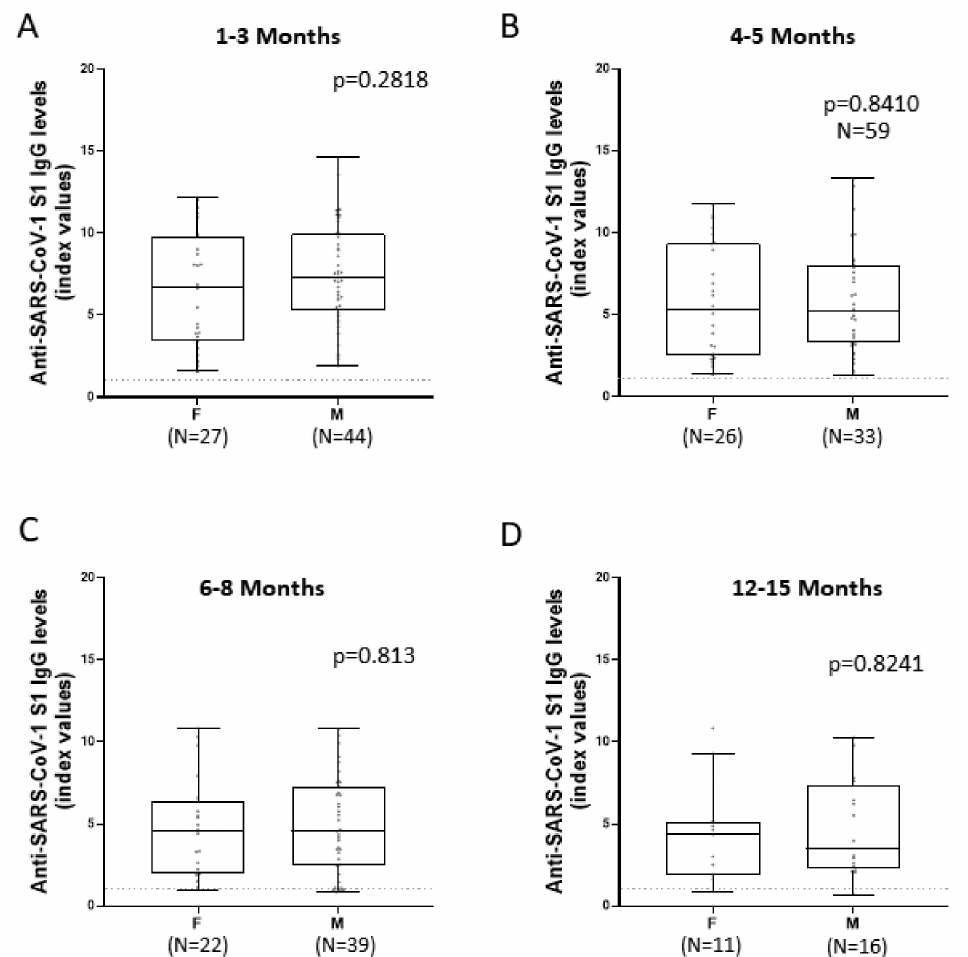
Figure 4. Comparison of IgG responses targeting SARS-CoV-2 S1 between female and male patients in various time-points. IgG responses were measured at various time-points and grouped into two categories, male and female. Statistical analysis occurred between female and male patients, regardless of the severity of their disease, and Mann–Whitney test ( A , B ) and Unpaired t test ( C , D ) were used to determine whether there was a significant difference between the antibody titers of the two groups at a certain time-point each time. Horizontal dashed lines represent the cut-off value of the assay used. Comparison of anti-SARS-CoV-2 IgG titers between female and male patients ( A ): In samples collected one to three months after infection. ( B ): In samples collected four to five months after infection. ( C ): In samples collected six to eight months after infection. ( D ): In sample collected twelve to fifteen months after